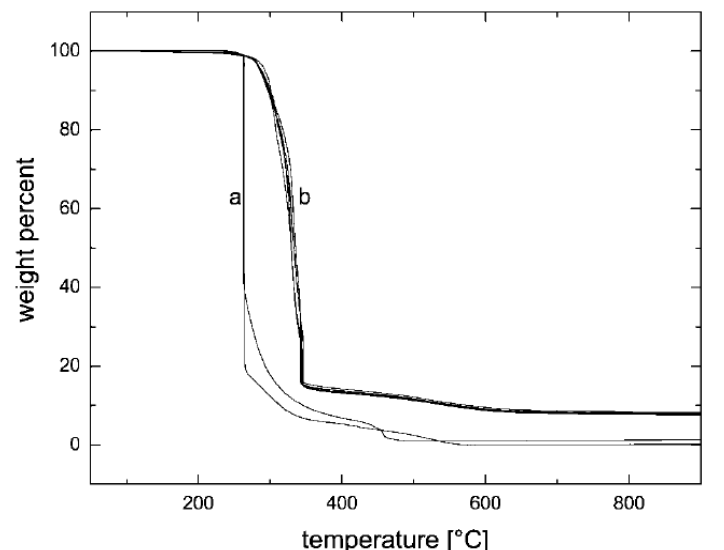
Figure 45. TGA thermograms of pure polymer and pure PP-g-MA compatibilizer (curves in group ‘a’) and polypropylene nanocomposites with 3 vol% of filler and containing 0, 2, 4, 6, 8 wt% of the compatibilizer (curves in group ‘b’). Reproduced from reference